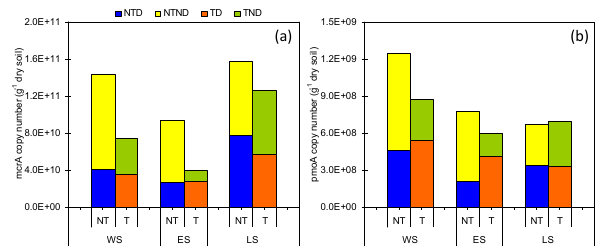
Figure 4. The abundance of methanogen and methanotroph popula- tions in paddy soil from 2013 to 2014. WS, ES, and LS mean winter fallow season, early-rice season, and late-rice season, respectively. creased the level of methanogens throughout the winter fal- low (Fig. 4a, P < 0.001) and following early- and late-rice seasons (Fig. 4a, P < 0.05). Relative to non-tillage treatments (NTND and NTD), tillage treatments (TND and TD) also sig- nificantly decreased the abundance of methanogens through- out the winter fallow and following early- and late-rice sea- sons (Fig. 4a, P < 0.001). The abundance of methanotrophs was highest in the winter fallow season, and then it gradually decreased (Fig. 4b). Drainage treatments (NTD and TD) relative to